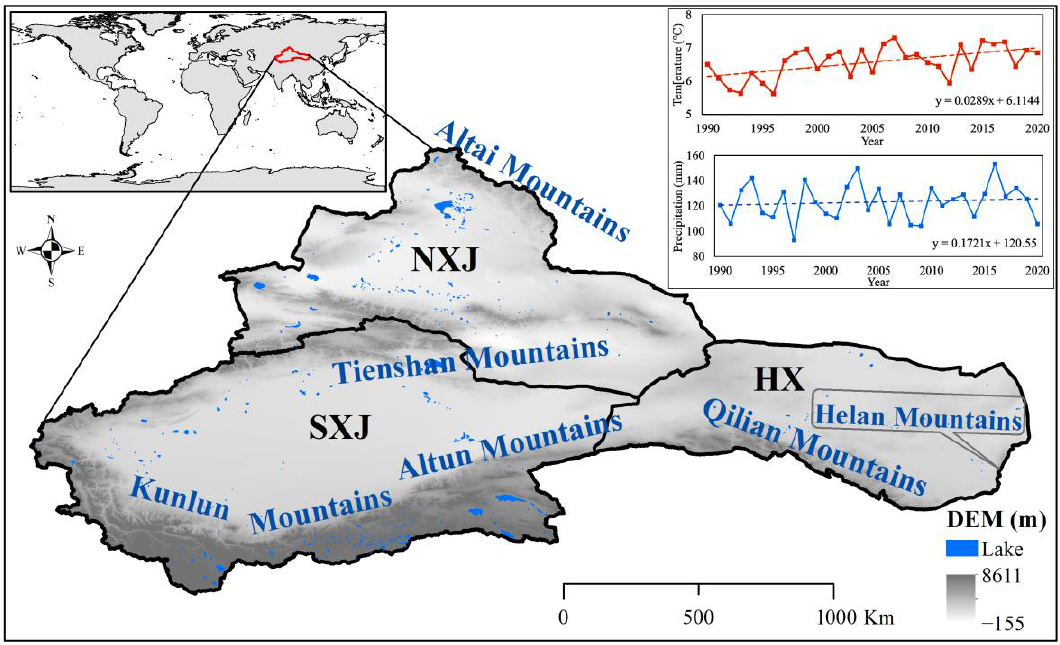
Figure 1. Map of the study